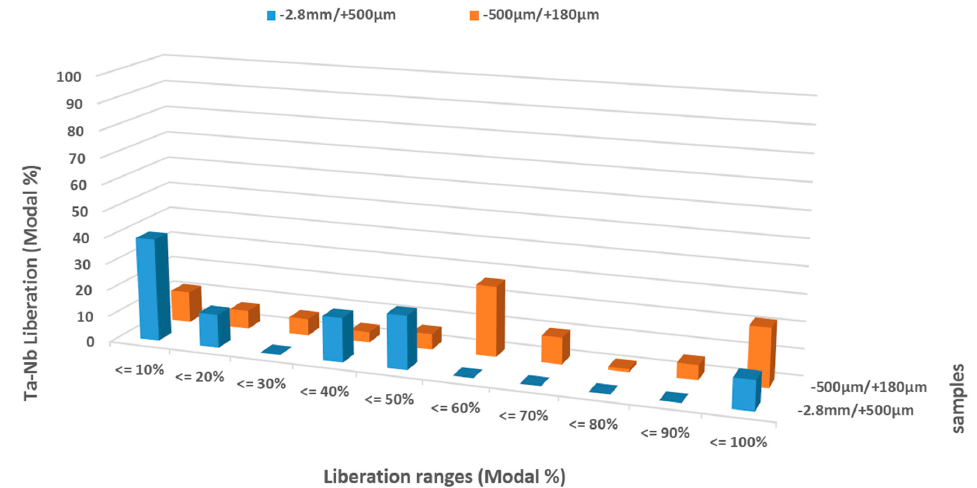
Figure 5. Ta–Nb liberation. Columbite, tantalite and microlite have been combined to give an overall liberation rate. 80% liberation is required for mineral processing.